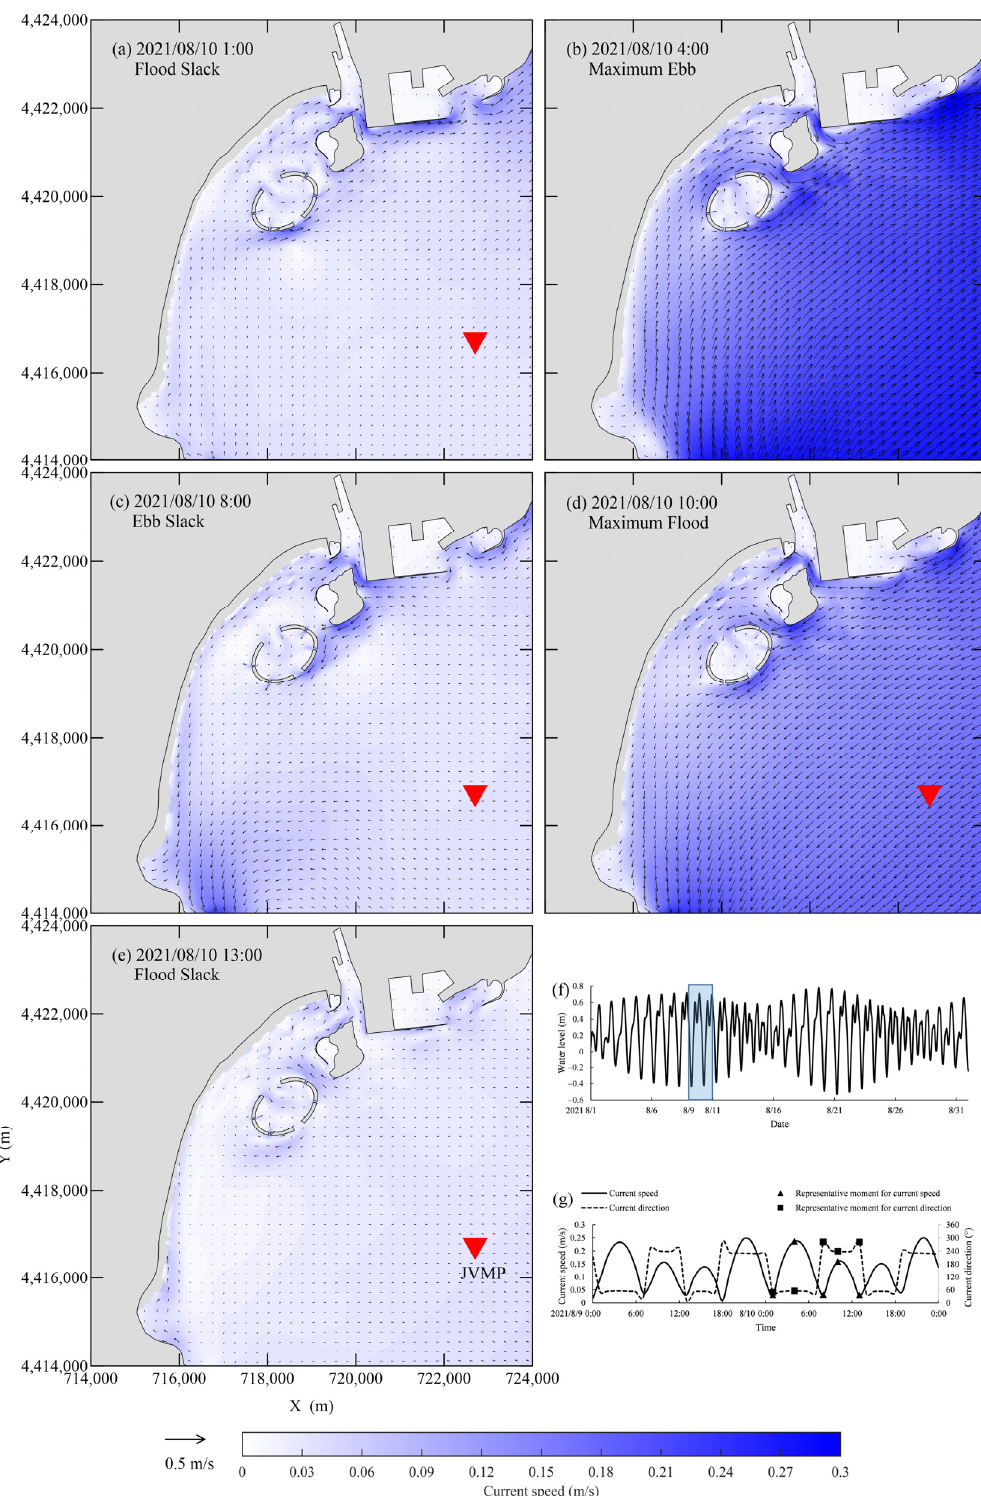
Figure 7. Current fields of a representative spring tidal cycle from 01:00 10 August 2021, to 13:00 10 August 2021, for the moments of ( a , e ) Flood slack; ( b ) Maximum ebb; ( c ) Ebb slack; and ( d ) Maximum flood; ( f ) Time series of the water level at JVMP for a spring–neap tidal cycle during August 2021. The blue shadow area represents the duration from 00:00 9 August 2021, to 00:00 11 August 2021. ( g ) Time series of the current speed and direction at JVMP from 00:00 9 August 2021 to 00:00 11 August 2021. The black triangles and squares represent the moments corresponding to ( a – e